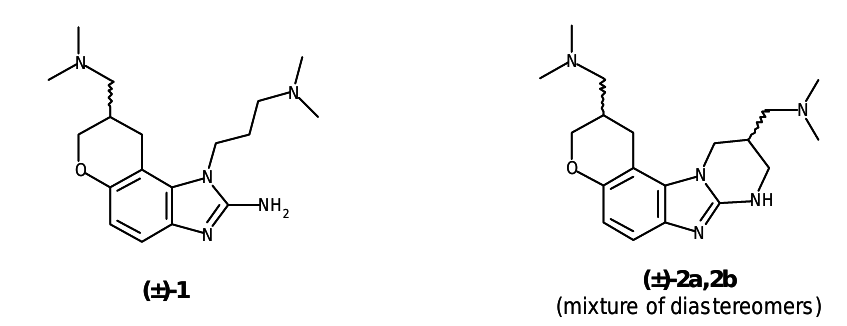
Figure 1. Dihydropyranobenzimidazole